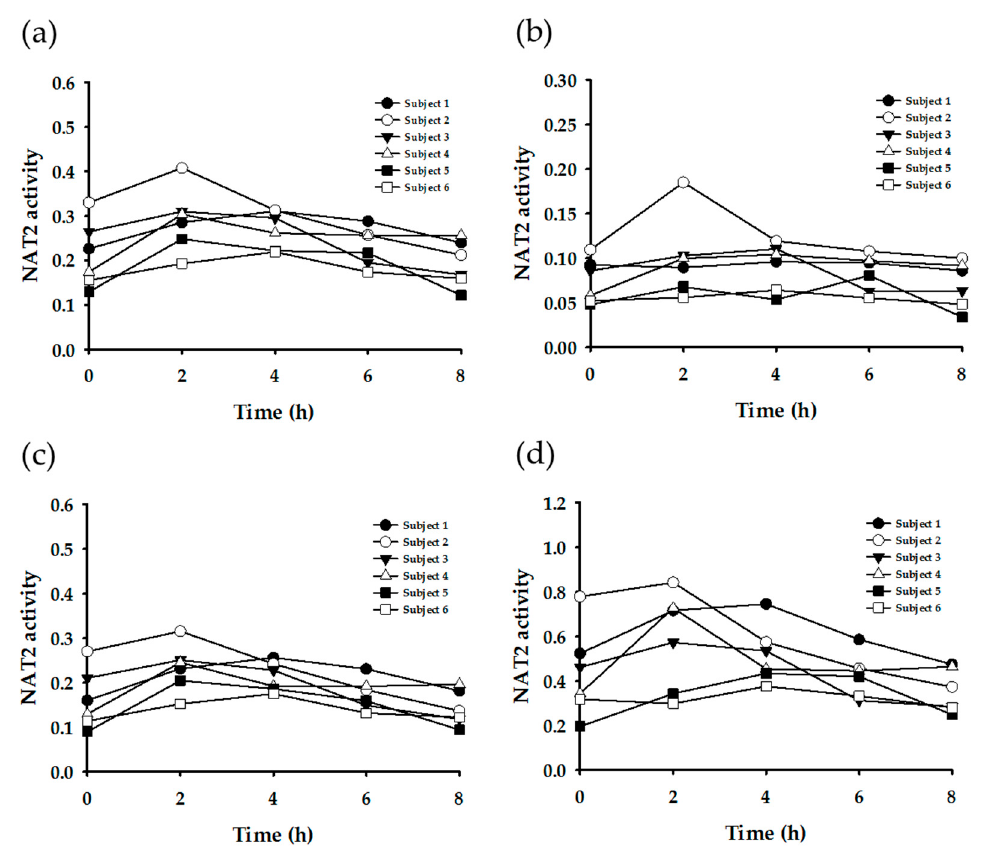
Figure 5. Plots of metabolite ratio for NAT2. The metabolic ratio equations used are as follows: ( a ) (AAMU+AFMU)/(AAMU+AFMU+1X+1U), ( b ) AAMU/(AAMU+1X+1U), ( c ) AFMU/(AFMU+1X+1U), ( d ) AFMU/1X.